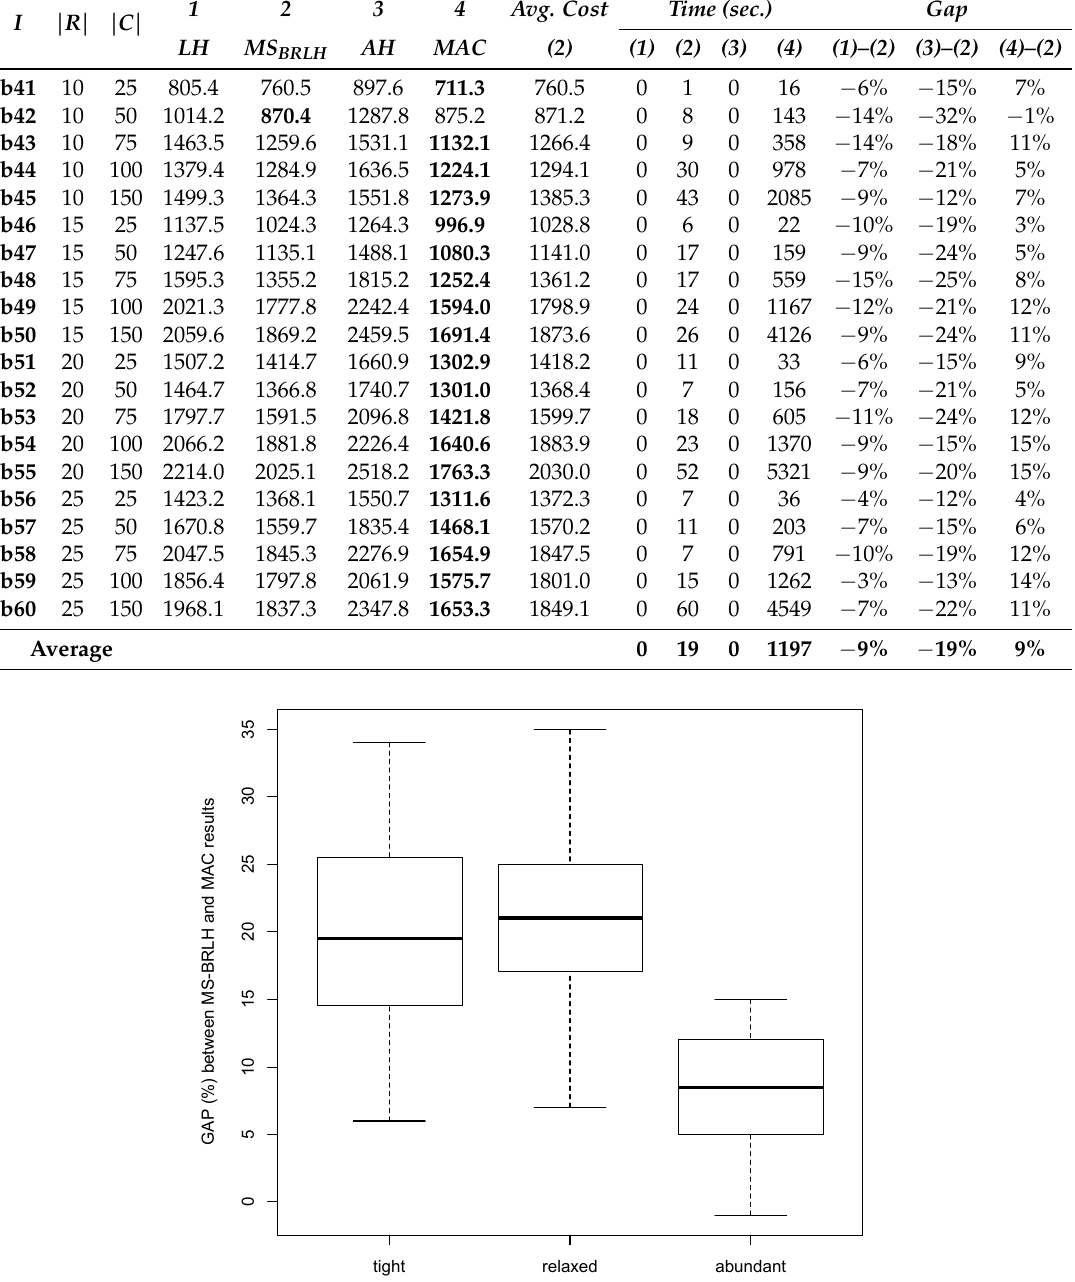
Table 5. Comparison of the results obtained by our methodologies (LH and MS BRLH ) with those obtained by Abdulkader et al. [1]’s methods (AH and MAC) in the abundant inventory scenario.